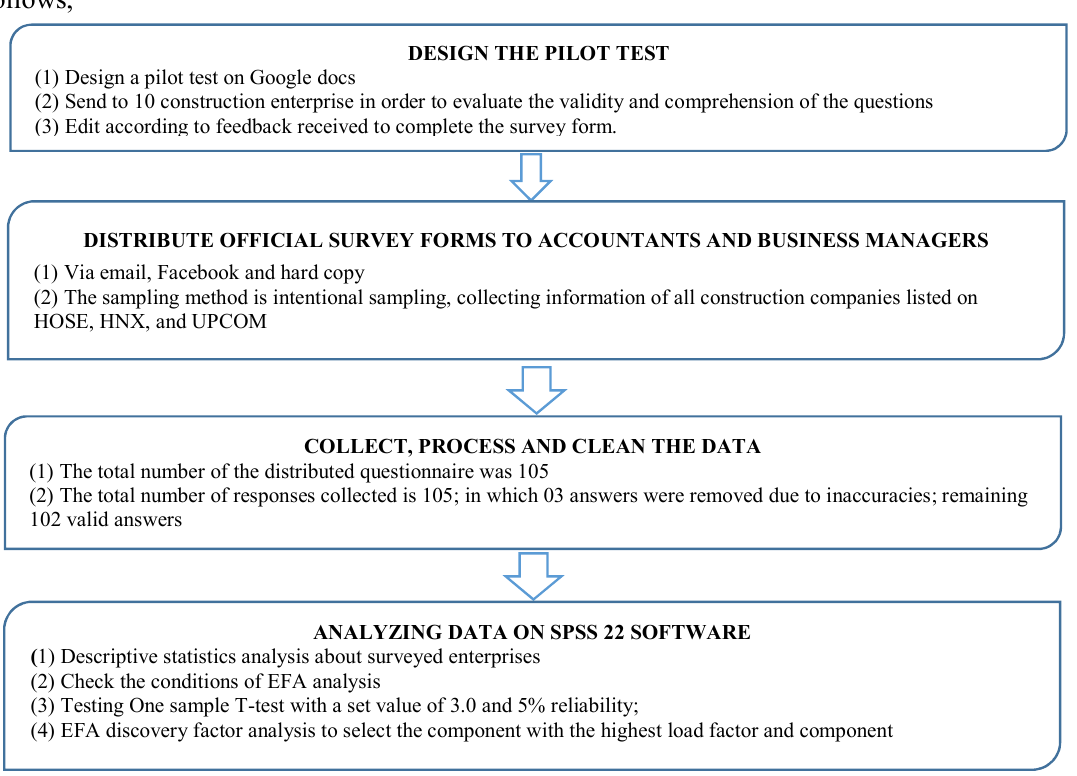
Fig. 1: Conceptual framework